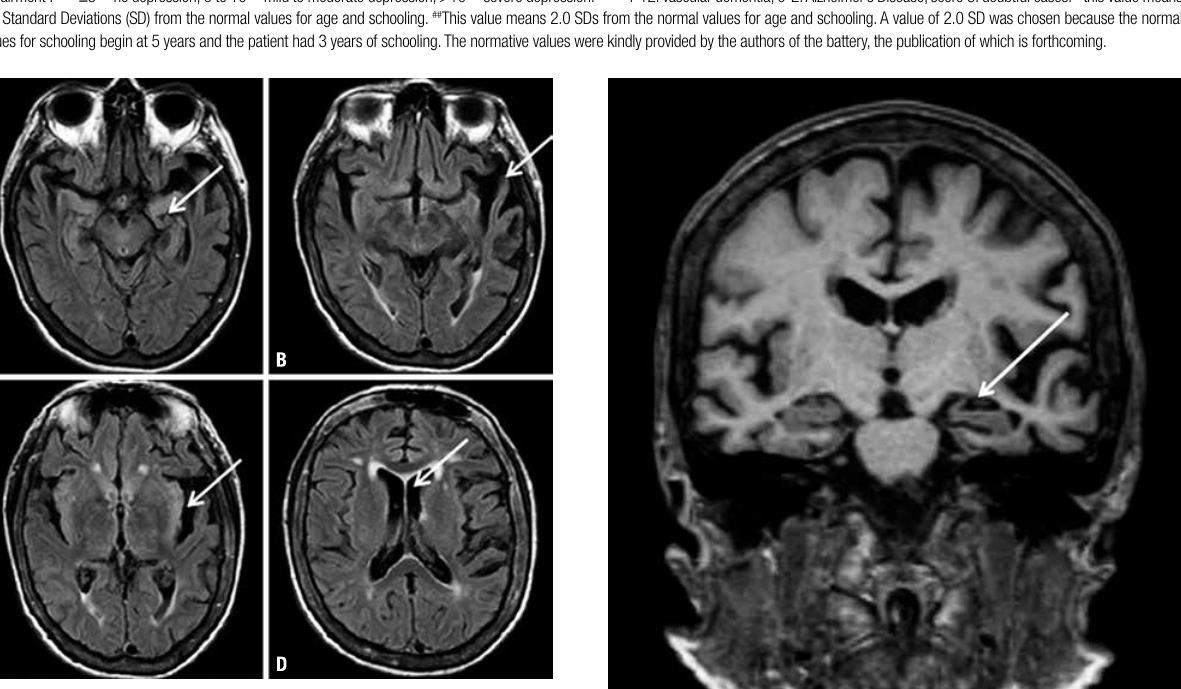
Patient score Scoring range